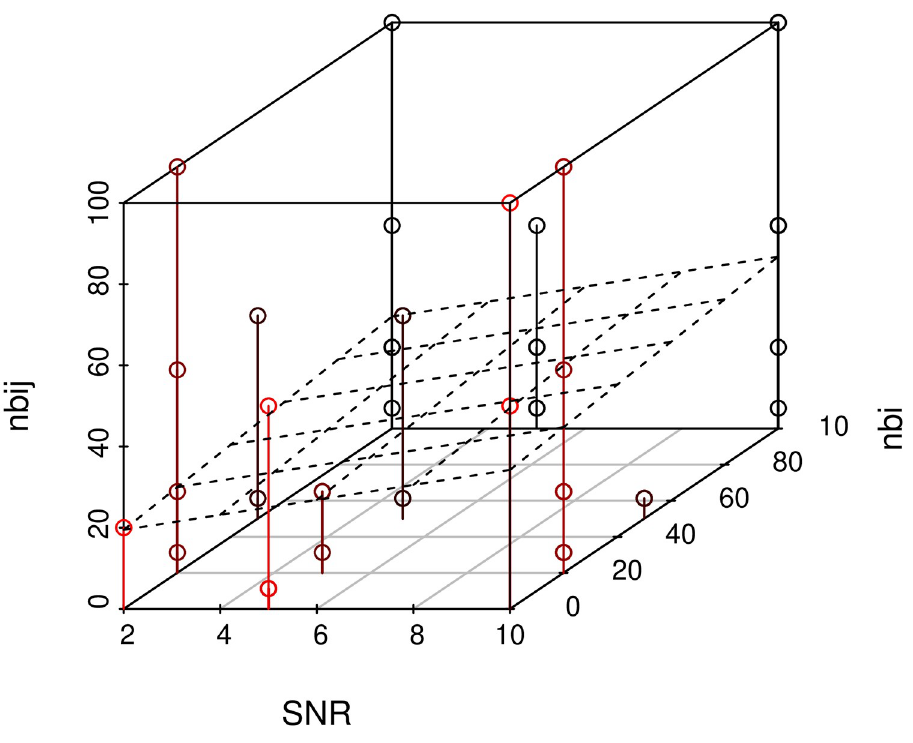
Fig 12. Distribution of xyz